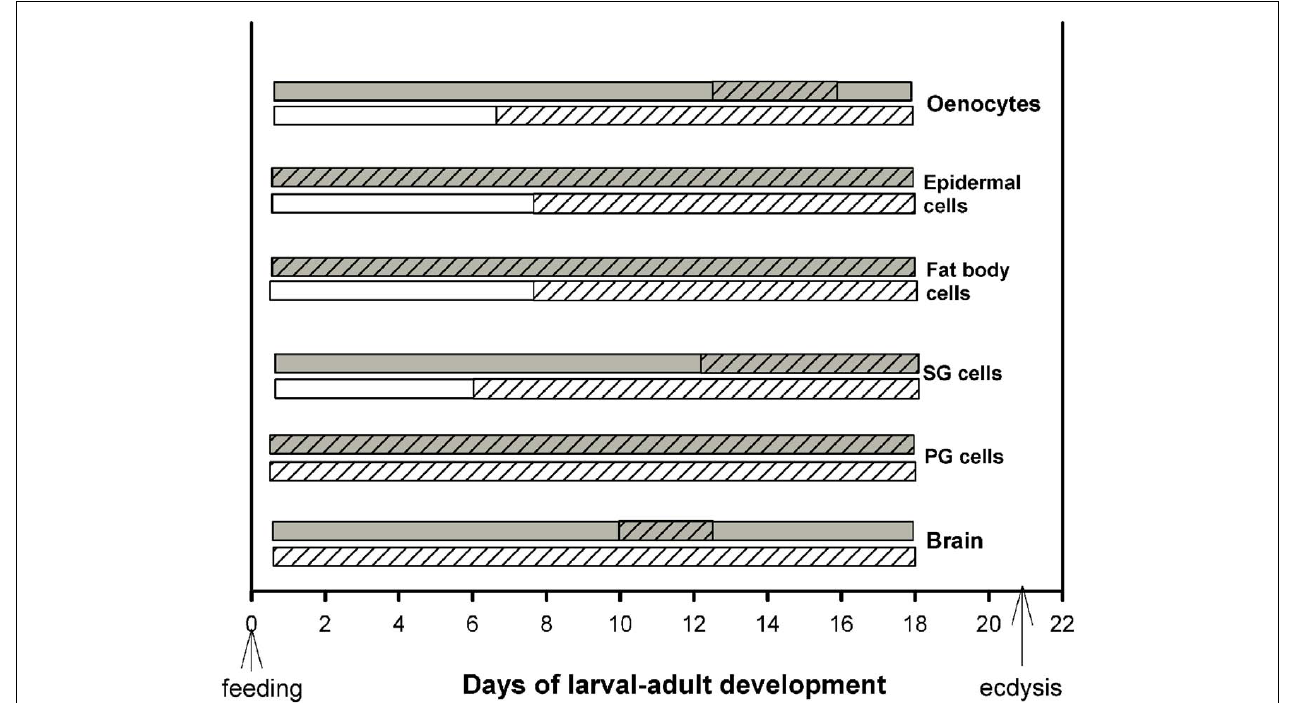
nucleus during the night of each tissue. Note that EcR is present for different lengths of developmental time in different tissues. Cytoplasmic-nuclear shuttling of EcR is necessarily confined to the developmental times when both the light and dark bars are hatched, i.e., EcR is present in both compartments during the same 24h period. For details, see